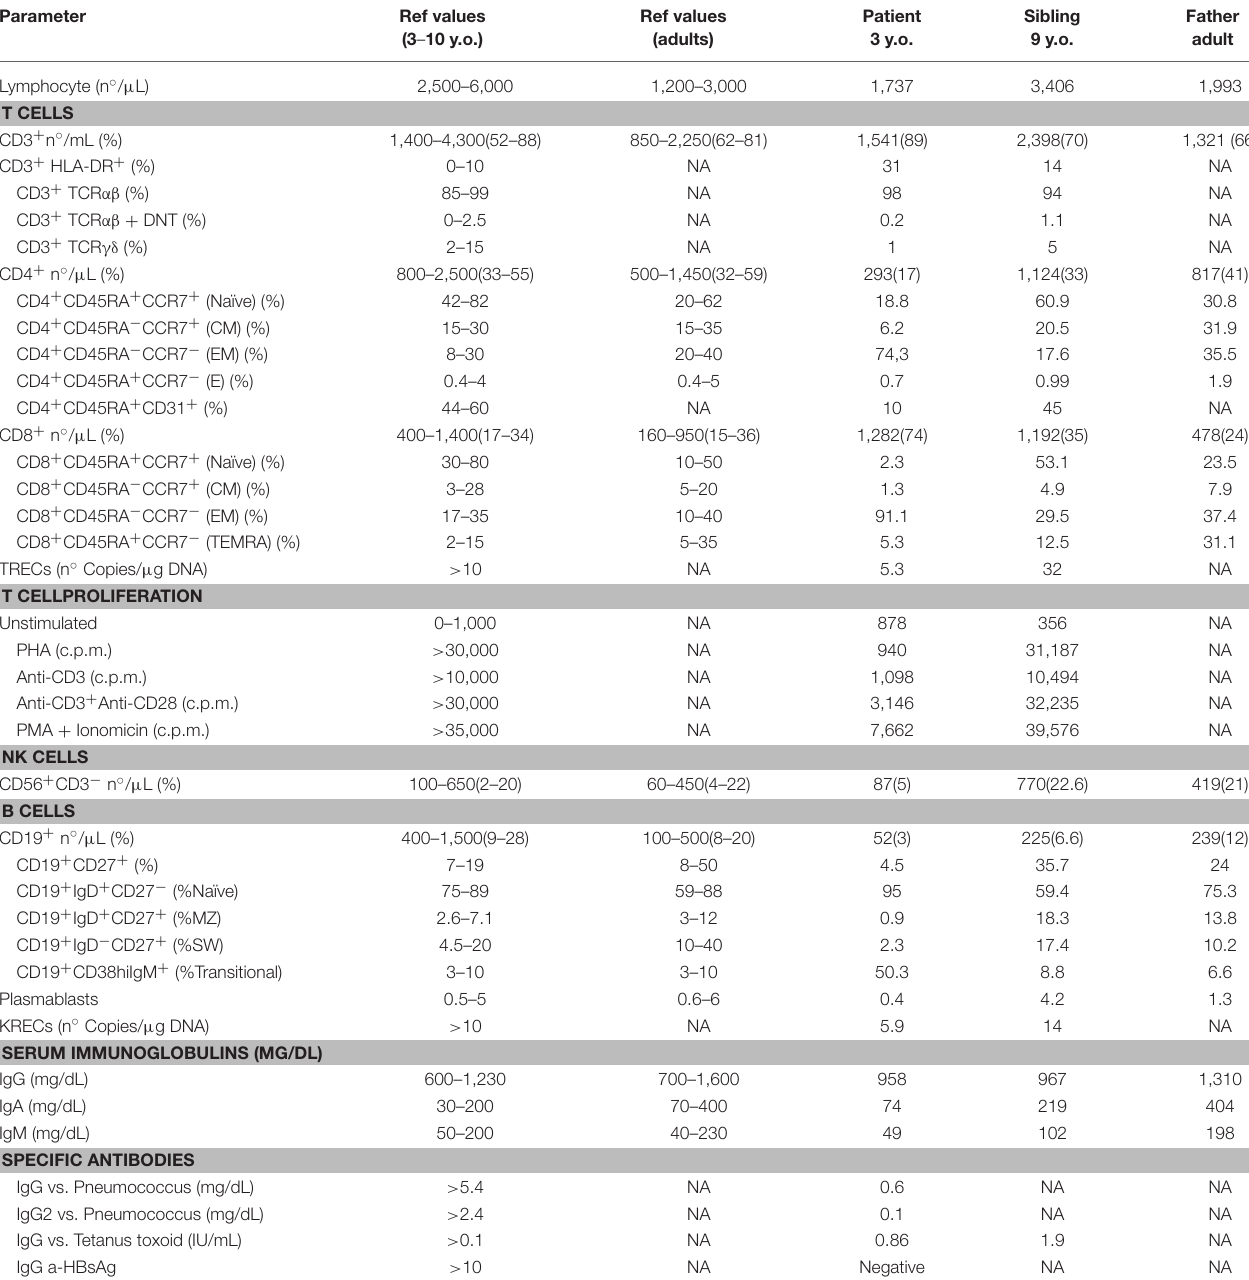
TABLE 1 | Immunologic features of the